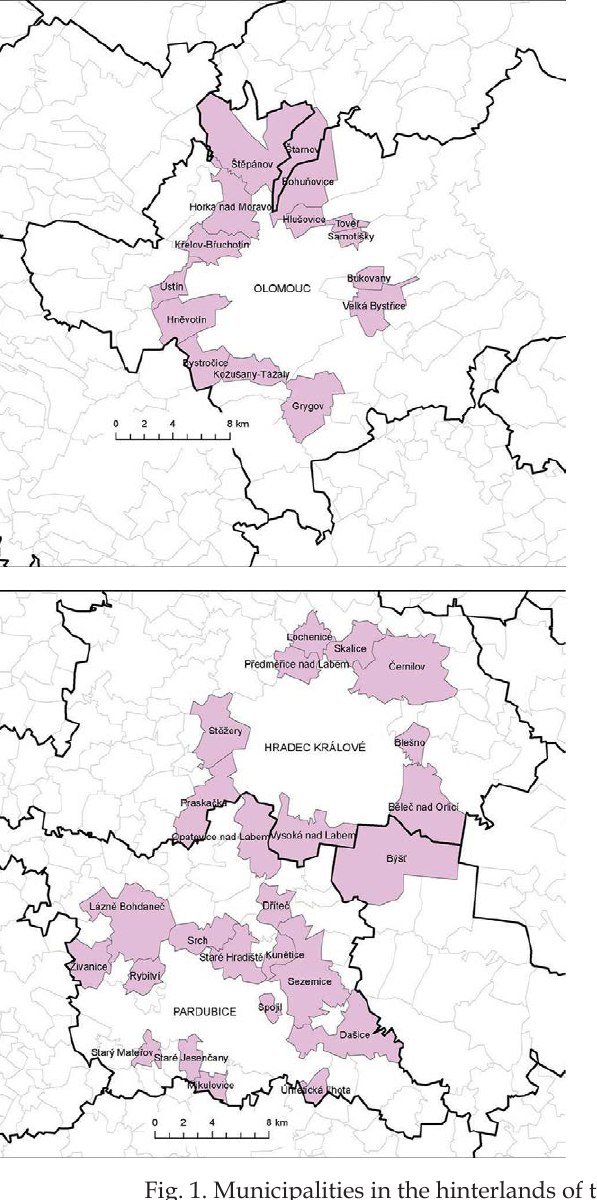
Fig. 1. Municipalities in the hinterlands of the core cities participating in the survey. Source: Survey in the municipalities in the hinterlands of core cities, GaREP,